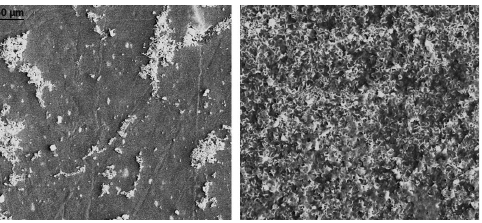
Figure A4. SEM image of PVC surface for non-ESD ( left ) and ESD ( right ) scaled to 50 µm.